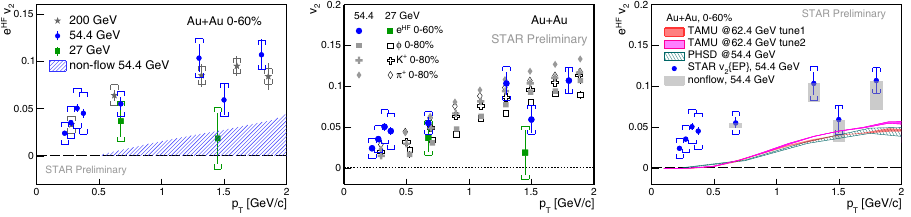
Figure 3. Left: HFE v 2 as a function of p T in 0–60% centrality of 27 and 54.4 GeV Au + Au collisions compared with that from 200 GeV Au + Au collisions. Middle: HFE v 2 as a function of p T compared to those of light flavor mesons in 27 and 54.4 GeV Au + Au collisions. Right: HFE v 2 as a function of p T , compared to TAMU and PHSD calculations in 0–60% centrality of 54.4 GeV Au + Au